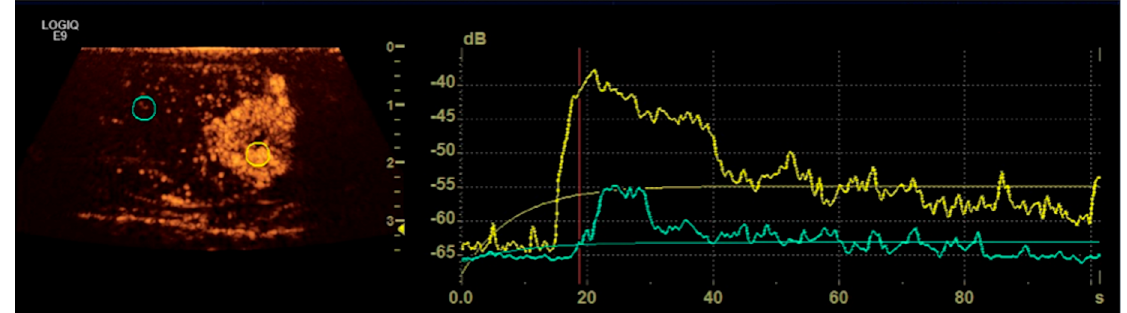
Figure 5. Representative image showing quantitative CEUS examination with ROIs positioned within the lesion (yellow ring) and in the normal parenchima (blue ring) respectively on the left and corresponding time-intensity curves in the right.